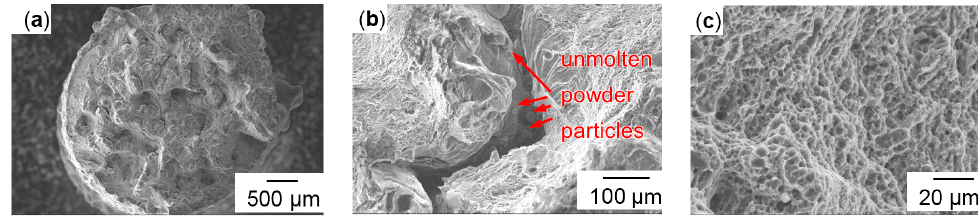
Figure 7. Horizontal non-heat-treated ( a ) overview; ( b ) unmolten particles; ( c ) fibrous structures.